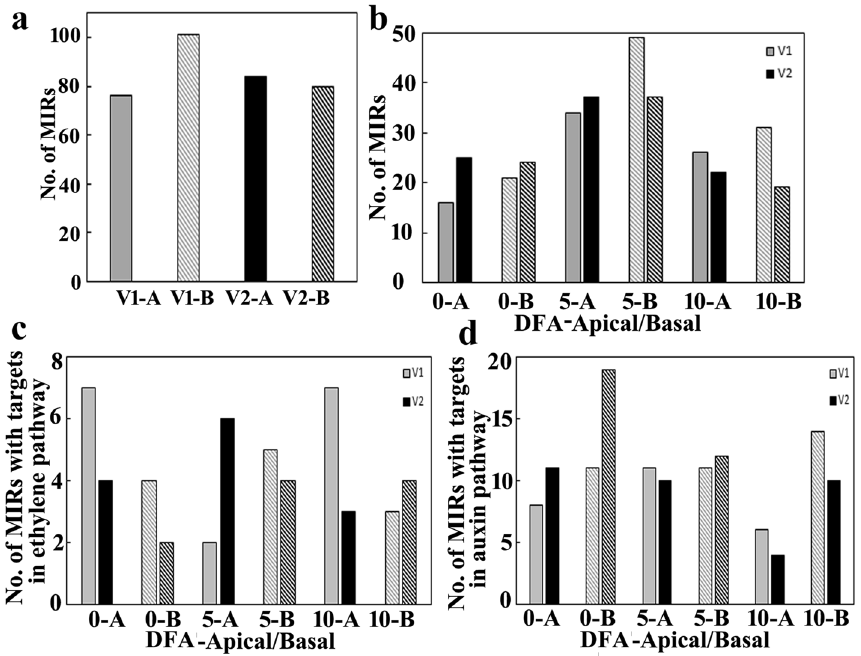
Figure 6. The number of unique miRNAs present in the apical and basal spikelets of either in V1 (SR-159) or V2 (SR-157) during post-anthesis (0, 5 and 10 days) taken together ( a ). The unique miRNA present in the apical and basal spikelets of V1 and V2 ( b ), miRNAs having target genes in the ethylene pathways in the apical and basal spikelets ( c ) and miRNAs having target genes in the auxin pathways in the apical and basal spikelets ( d ) arranged separately during post-anthesis (0, 5 and 10